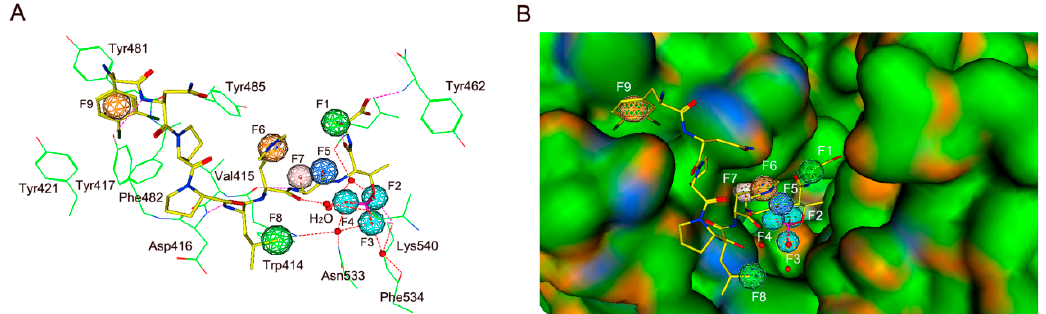
Figure 3. ( A ) The 3D ligand–protein interaction diagram and pharmacophore mapping of peptide 5 in the binding site of PLK1-PBD (PDB ID: 3Q1I). ( B ) Key interactions involved in stabilizing peptide 5